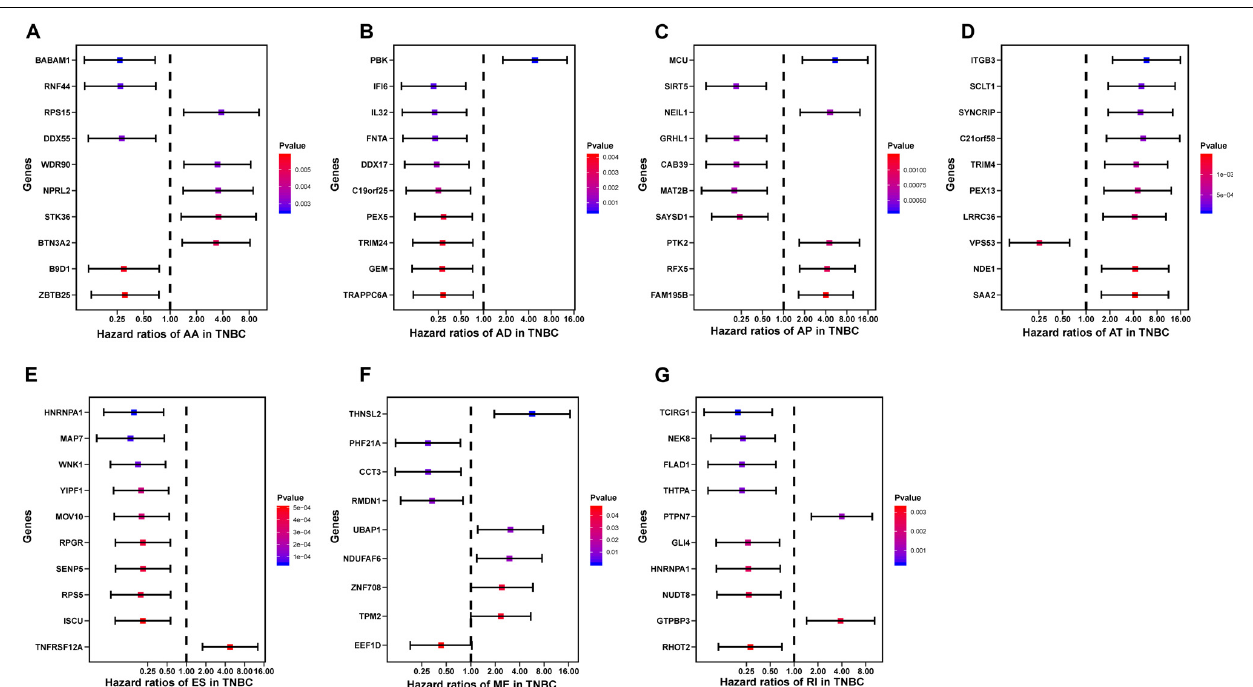
FIGURE 4 | The forest plots of the top 10 prognosis-associated AS events in TNBC. (A–G) HR of the top 10 prognosis associated AS parent genes, including AA subgroup (A) , AD subgroup (B) , AP subgroup (C) , AT subgroup (D) , ES subgroup (E) , ME subgroup (F) , and RI subgroup (G) events. The Circles represent HR and Horizontal bars represent 95% CIs. p -Values of univariate Cox analyses are indicated by color scale on the right